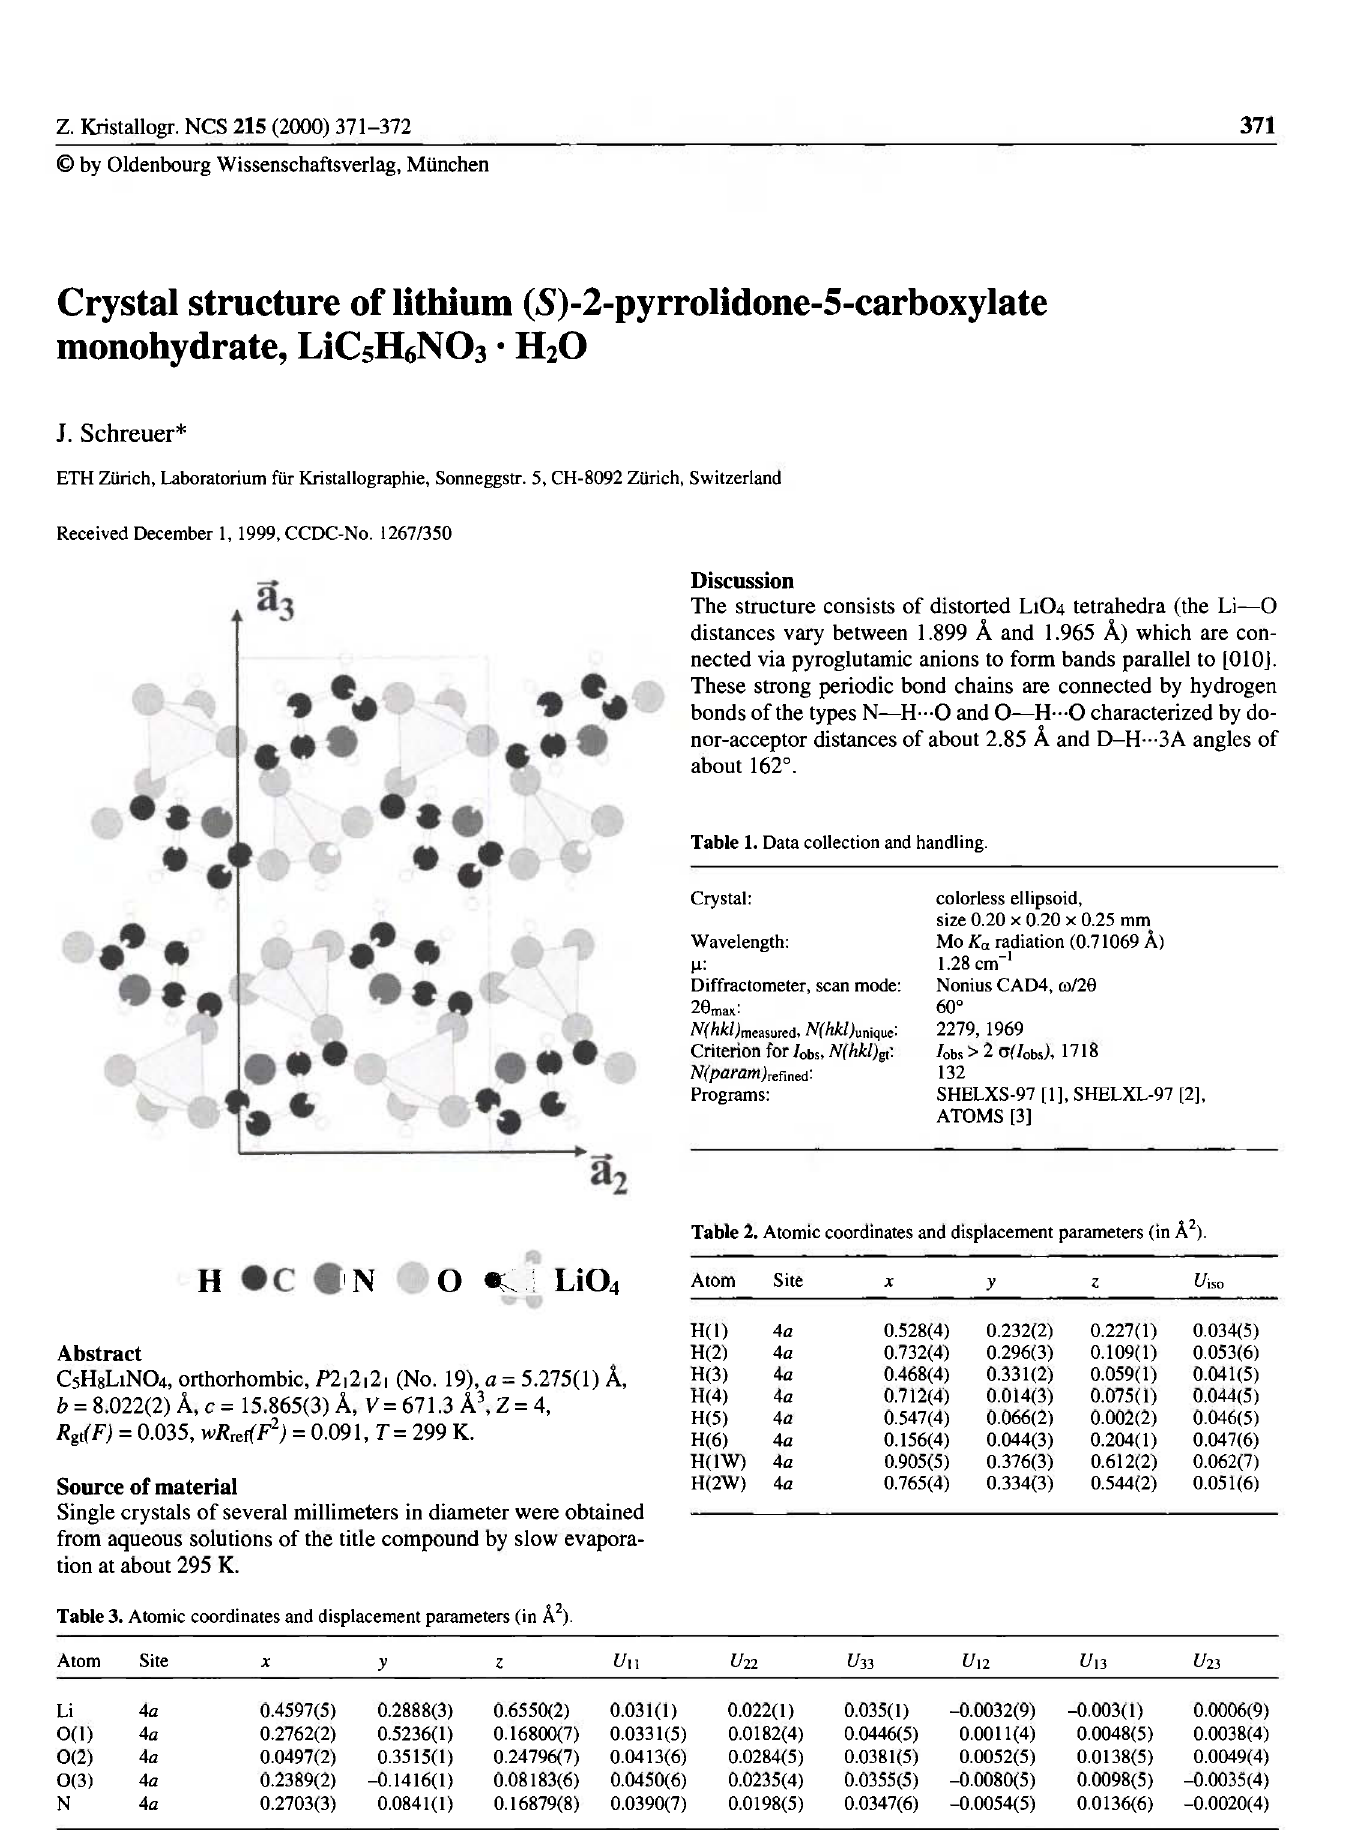
Table 3. Atomic coordinates and displacement parameters (in Ä 2 ).